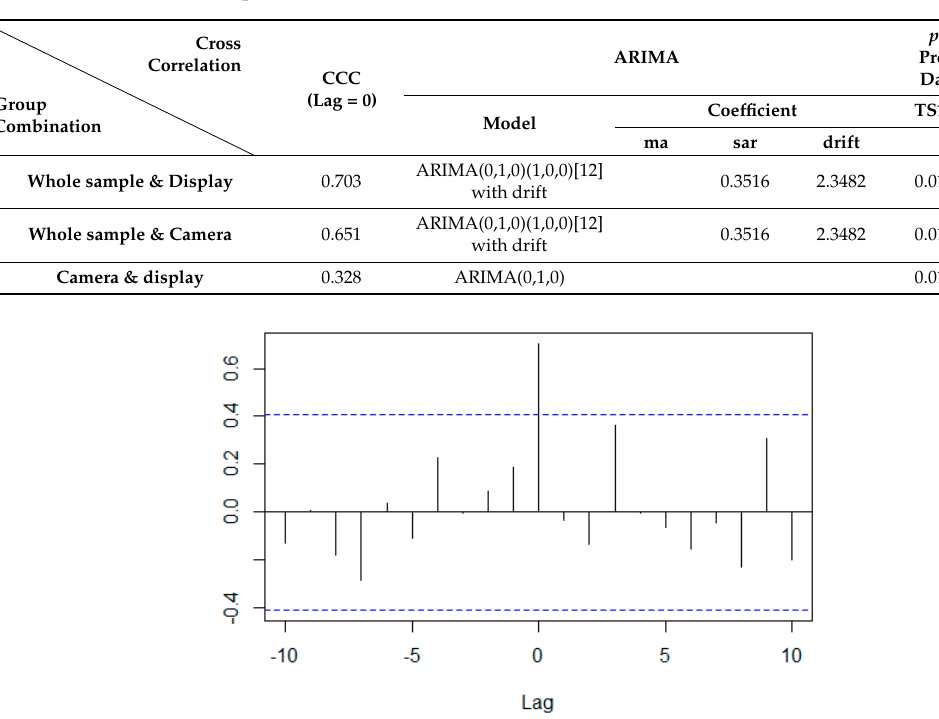
Figure 6. Cross-correlation coefficient between the average CAR of the whole sample group and the average CAR of the display group for Evaluation period: the month in which each company was listed-2008, Event period: 2010–2012.